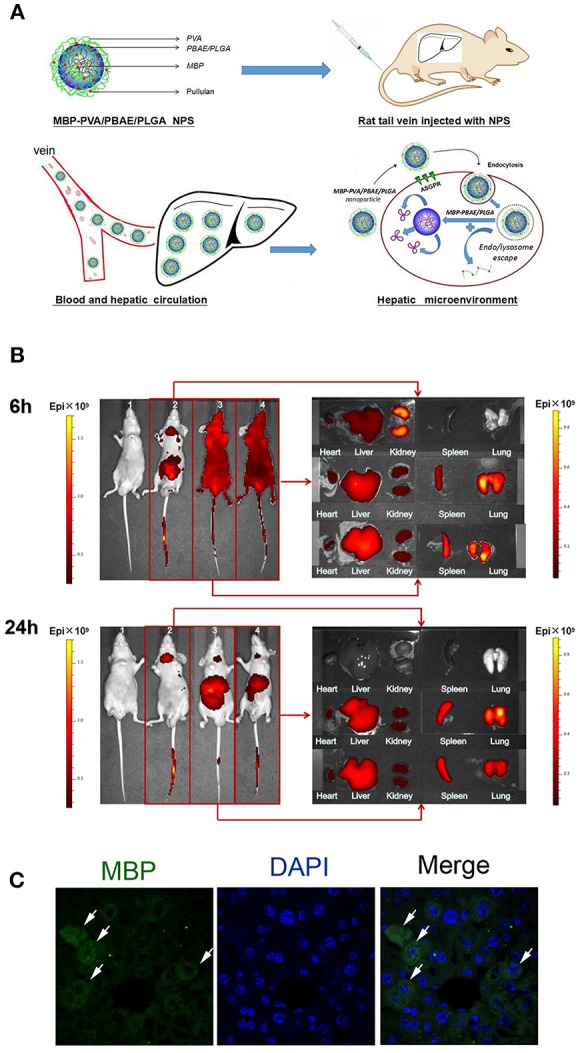
(A) Schematic diagram of the structure of MBP-PVA/PBAE/PLGA nanoparticles and the release mechanism of nanoparticles in the liver. (B) Exploration of the distributions of free Cy5.5, PVA/PBAE/PLGA/Cy5.5, and PBAE/PLGA/Cy5.5 nanoparticles in nude mice organs at 6 and 24 h. Small animals were imaged in vivo (1: saline-injected group; 2: free Cy5.5-injected group; 3: PVA/PBAE/PLGA/Cy5.5 nanoparticle-injected group 4: PBAE/PLGA/Cy5.5 nanoparticle-injected group). (C) Immunofluorescent staining of MBP in PVA/PBAE/PLGA/MBP nanoparticles-treated liver.